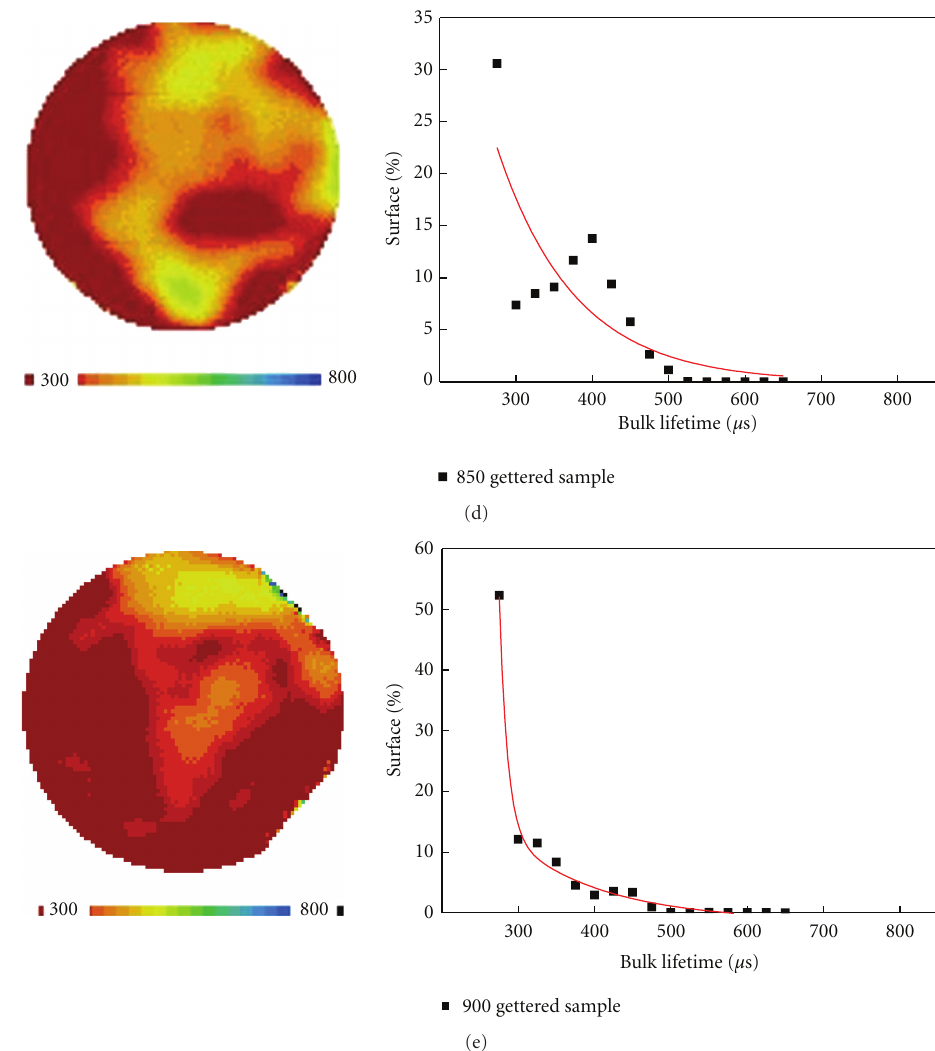
Figure 4: Mapping of bulk lifetime and its probability distribution for (a) nongettered sample and gettered samples at (b) 750, (c) 800, (d) 850, and (e) 900 ◦